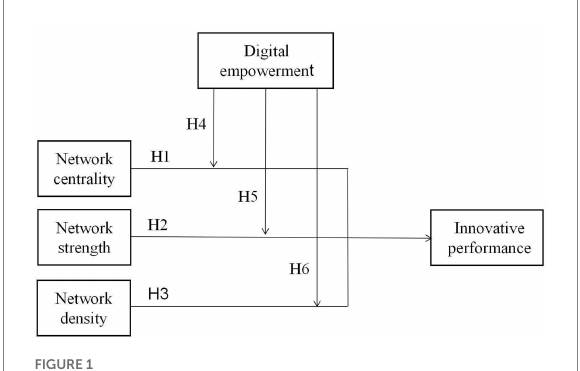
FIGURE 1 Theoretical framework of cluster innovation performance